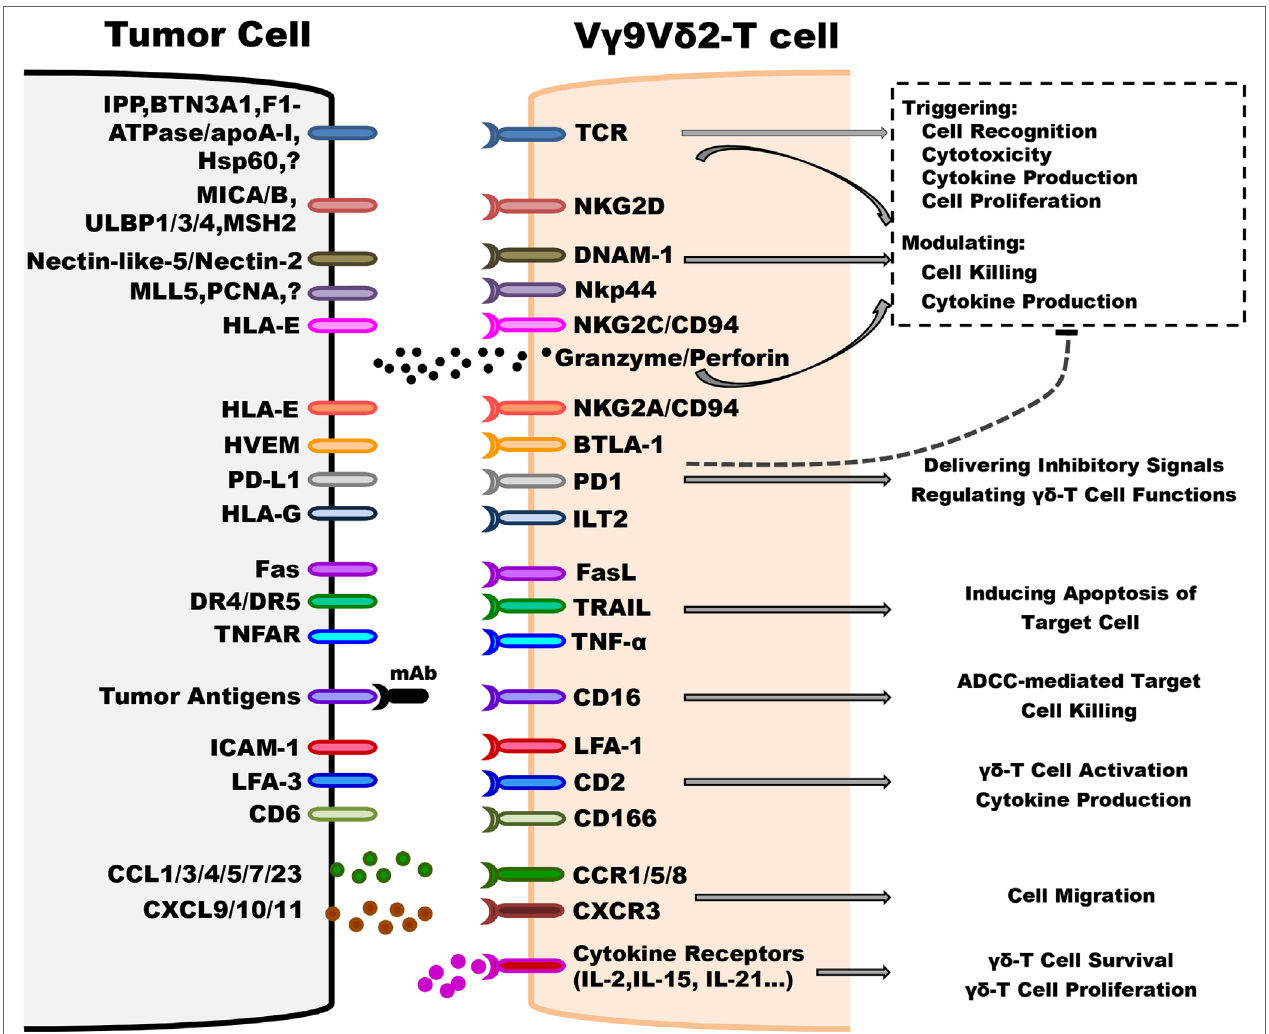
FigURe 1 | Underlying mechanisms implicated in regulating antitumoral activity of V γ 9V δ 2-T cells. V γ 9V δ 2-T cells can distinguish between tumorous and normal cells using T cell receptor (TCR) and other innate receptors to sense isopentenyl pyrophosphate (IPP) levels and stress signals (such as MICA/B, ULBP4, and MSH2) displayed on target cells. Most importantly, TCR γδ is the predominant factor that can trigger cell activation without any contribution of other co-stimulators, such as NKG2D. Following TCR-dependent activation, V γ 9V δ 2-T cells recognize and kill tumor cells by releasing effector molecules, such as granzymes and perforin, and Th-1 cytokines, inducing target cell apoptosis via Fas/FasL, TNF-related apoptosis-inducing ligand (TRAIL) and TNF- α pathways, and antibody-dependent cell-mediated cytotoxicity through CD16 expression. The activation threshold is finely regulated by inhibitory receptors, such as NKG2A/CD94. Moreover, adhesion patterns, such as lymphocyte function-associated antigen 1 (LFA-1)/intercellular adhesion molecule-1 (ICAM-1), are also involved in regulating the antitumoral activity of V γ 9V δ 2-T cells. The chemokine receptors, including CCR5, control the ability of V γ 9V δ 2-T cell to migrate to the tumor site. The survival and proliferation of V γ 9V δ 2-T cells are mostly modulated by different cytokines, such as IL-2 and